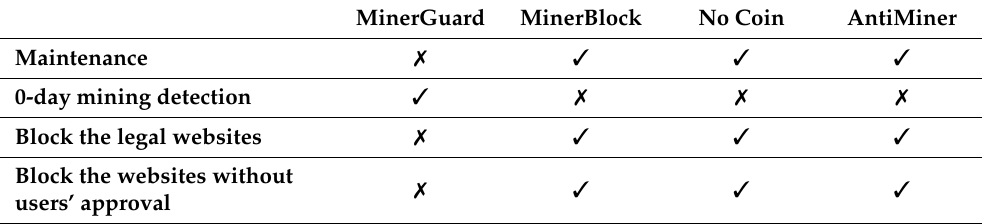
Table 5. Comparison table.